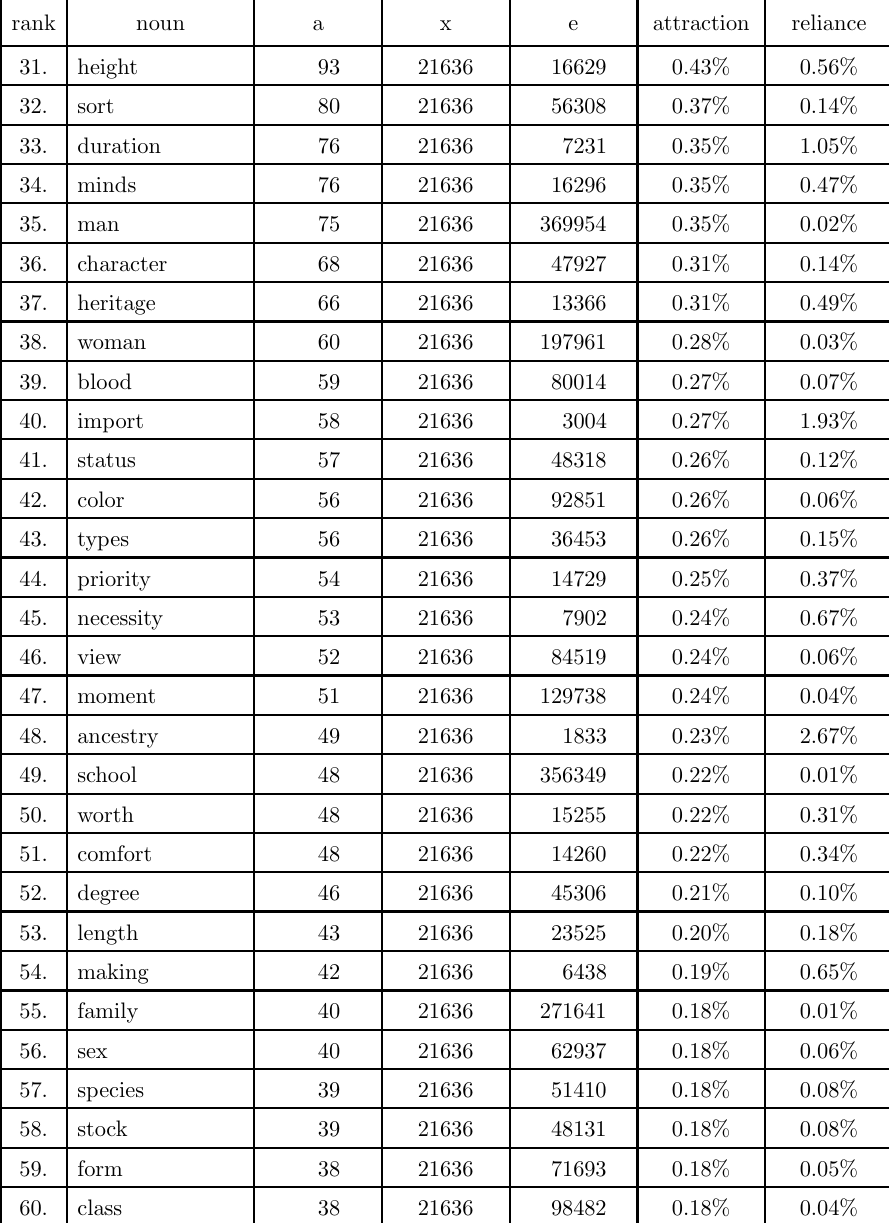
The results of attraction and reliance for the next 30 most